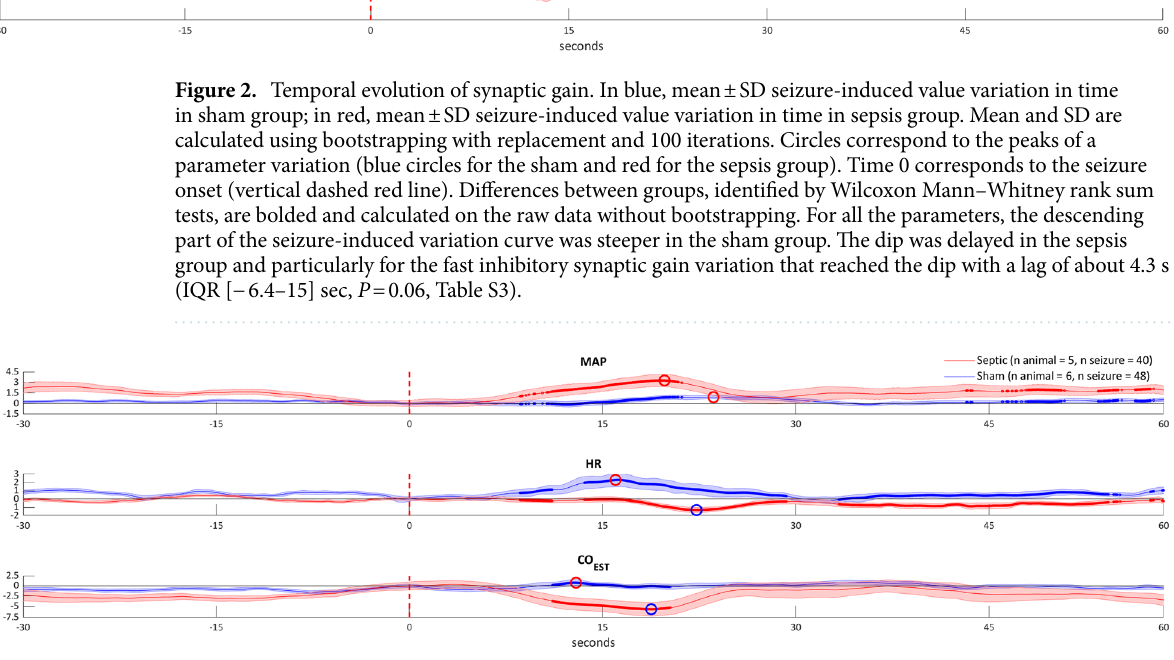
Figure 3. Systemic effects of seizures in the sham and sepsis groups. MAP: mean arterial pressure, HR: heart rate, CO EST : cardiac output estimation. See Fig. 1 for methodological explanations. The ictal MAP variation in the sepsis group is greater, whereas HR and CO EST response in inverted in comparison to the sham group (see text for